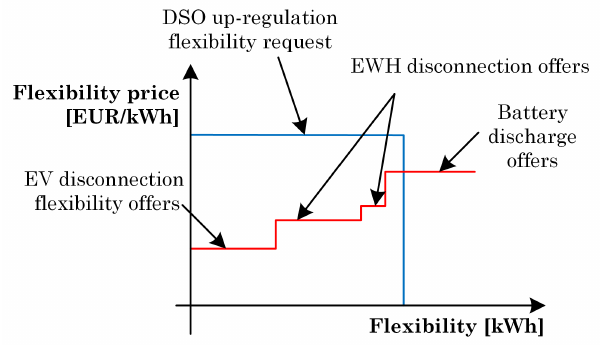
Figure 6. Local flexibility market auction